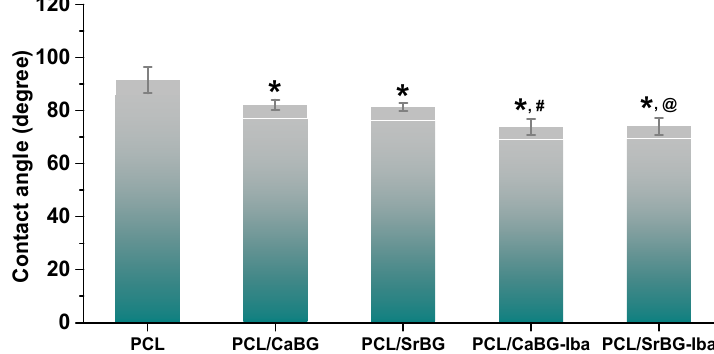
Figure 10. ( a ) Elastic Modulus and ( b ) Hardness of PCL membranes. *: p < 0.05.